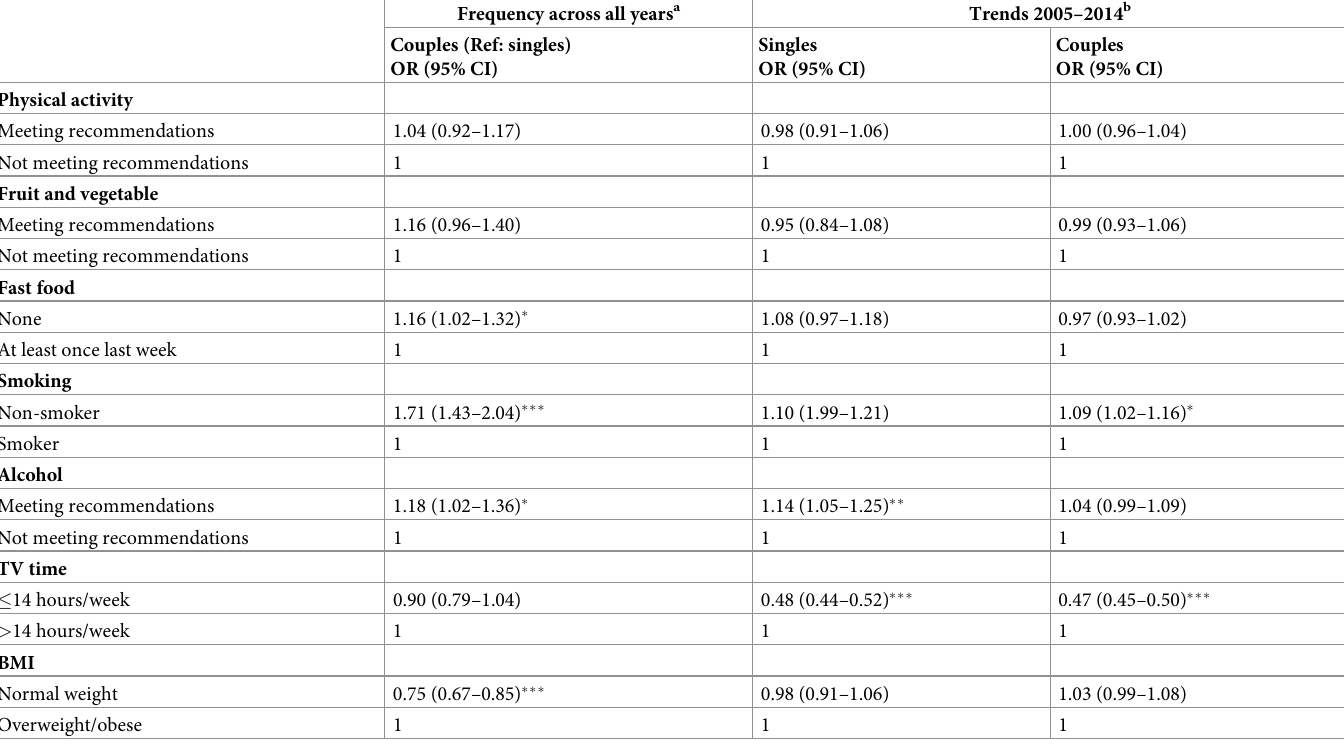
Table 3. Frequency and trends in healthy lifestyle factors by relationship status adjusted for other healthy lifestyle